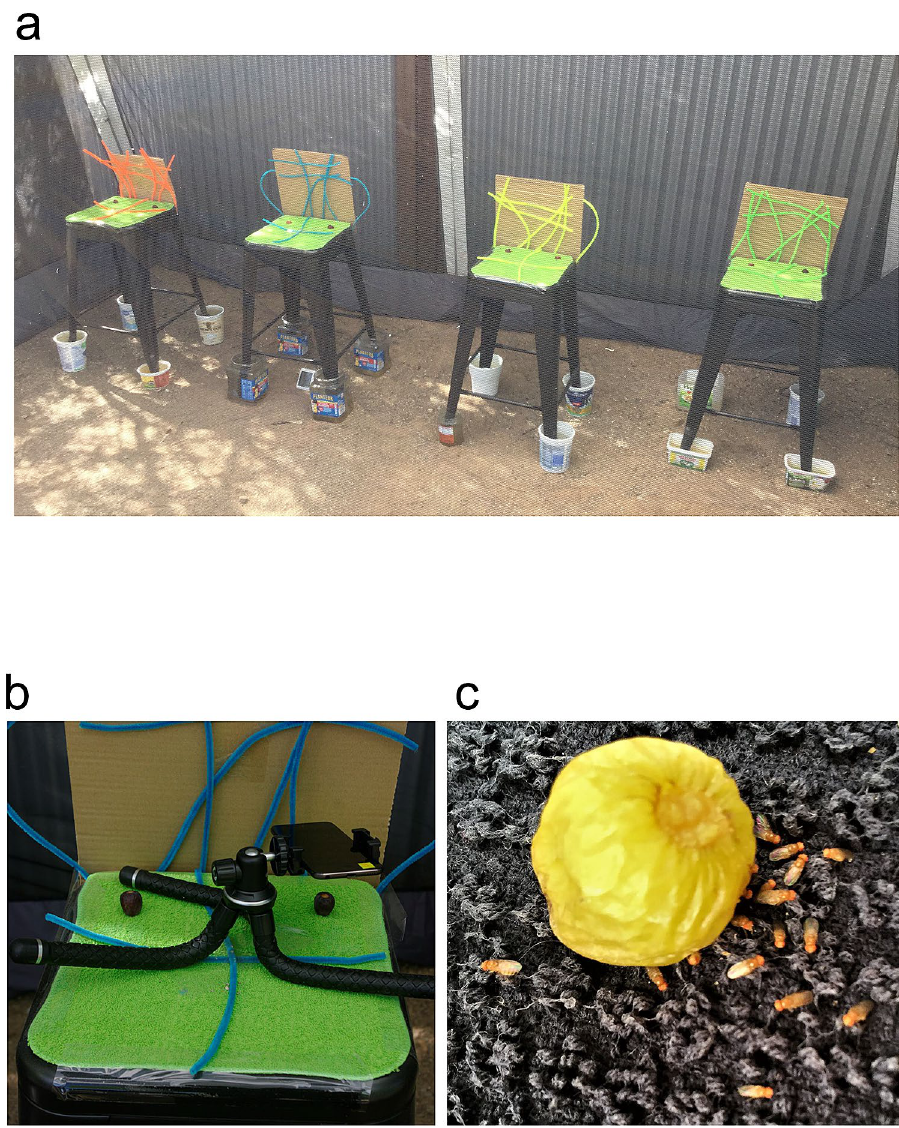
Figure 1. ( a ) The screen enclosure used in the observations was 3 m wide, 3.6 m long and 2.15 m high, and contained 4 stools, each with 2 grapes at the top. The ~ 50 flies inside the enclosure were free to choose their preferred activities and locations. ( b ) A close-up of a stool with 2 grapes and an iPod used for video recording. ( c ) A resting group of 18 flies near a grape at noon, when the temperature was 33 °C. This group constituted about 40% of the flies in this setting and each fly could choose to rest anywhere in the enclosure as well as at 7 other